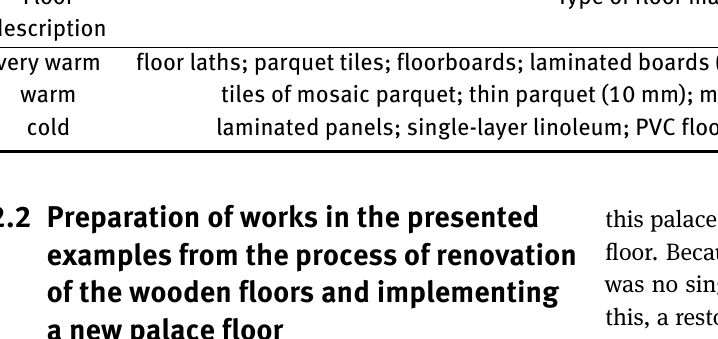
Table 1: Characteristics of the touch heat of particular types of floor materials Floor description very